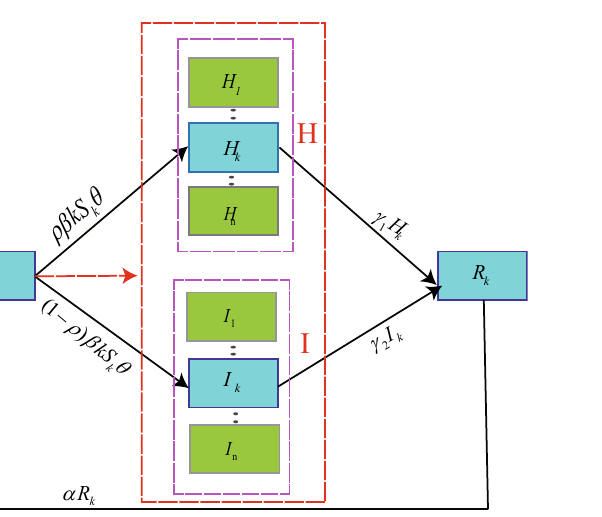
Figure 2. Schematic diagram of the SHIRS based on degree, the parameters meaning are listed in Table